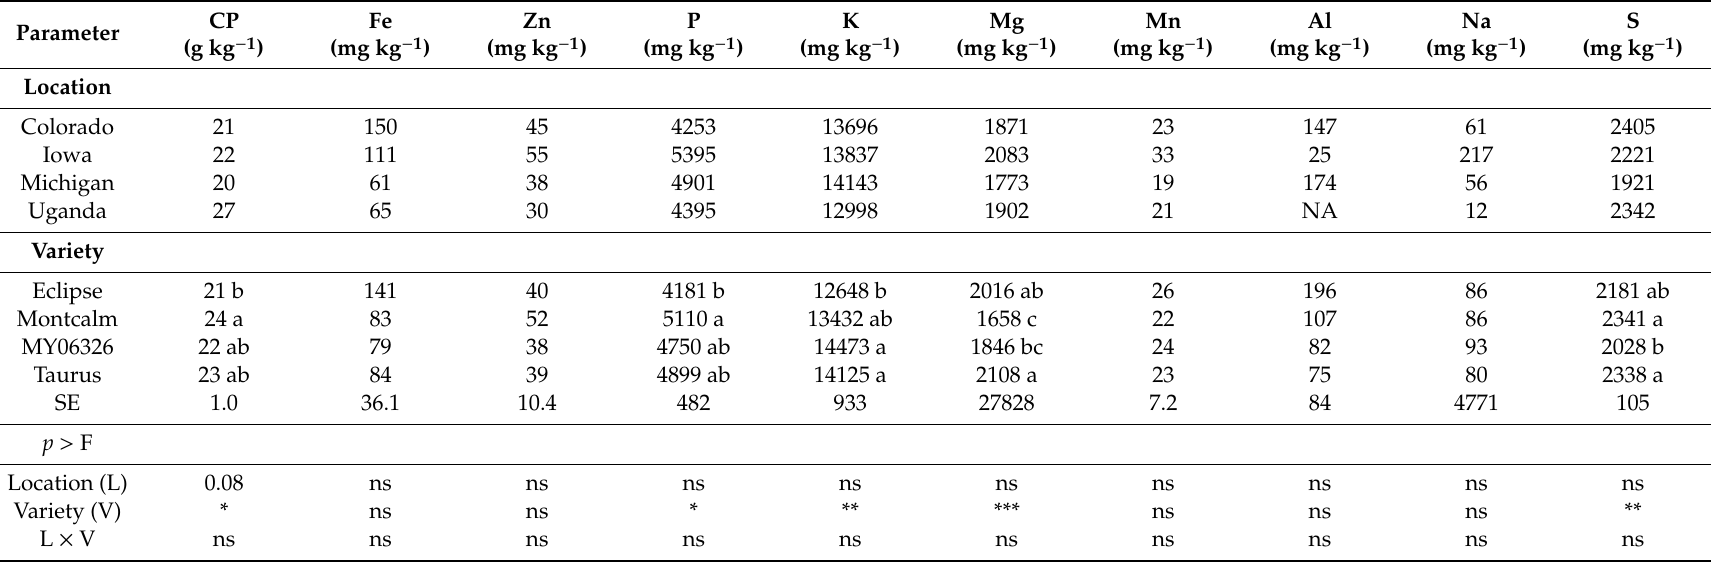
Table 4. Mean grain elemental and crude protein (CP) composition of four common beans varieties grown in four locations and two years.